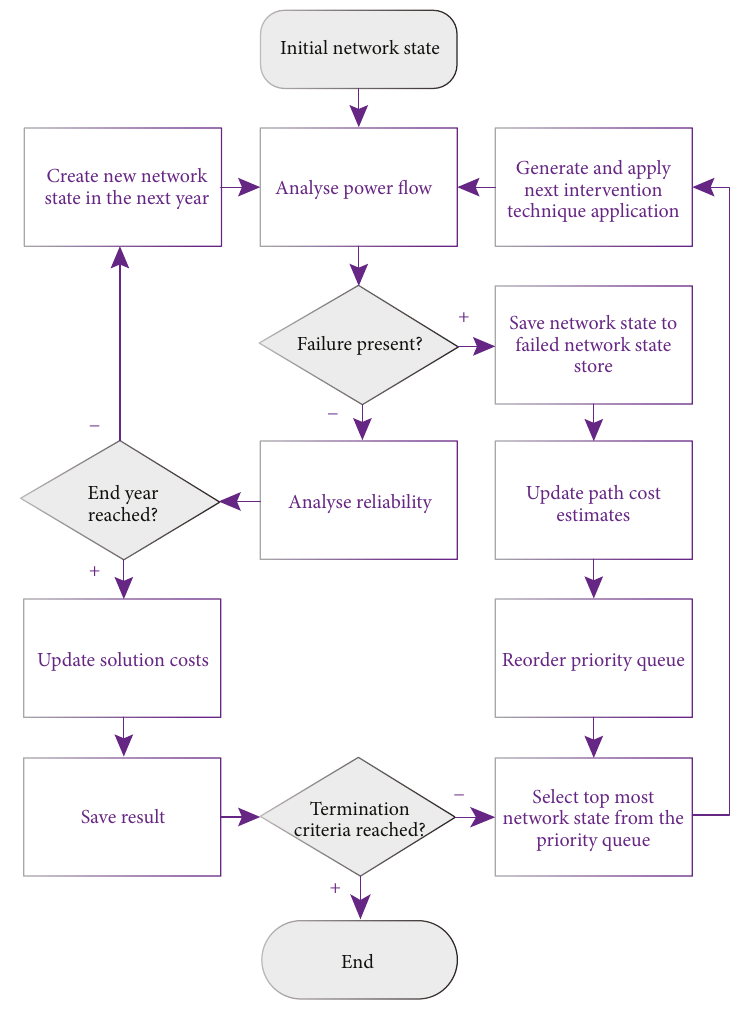
Figure 6: SIM evaluation fl